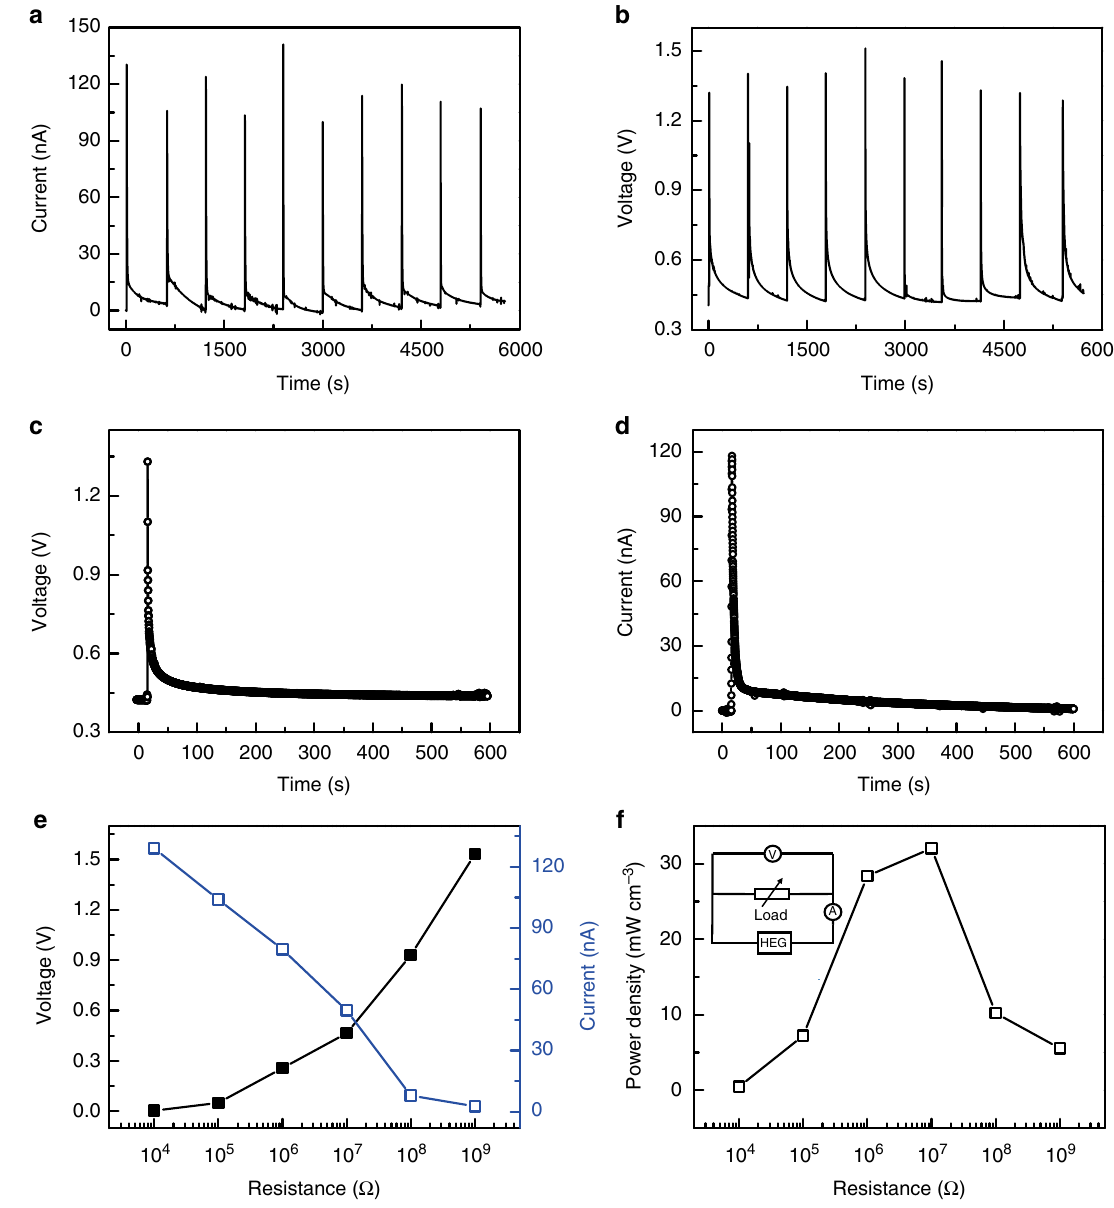
Fig. 3 Electric output performance of hygroelectric generator. a , b Voltage and current output cycles of HEG (Ag/graphene oxide (GO) – gradient reduced graphene oxide (grGO)/Au) in response to the intermittent and periodic relative humidity variation ( △ RH = 80%). HEG (Ag/GO – grGO/Au) is composed of a pair of Au, Ag electrodes, and heterogenous graphene oxide (h-GO) in which the Au electrode contacts with graphene oxide (GO) side of h-GO, while Ag electrode contacts with gradient reduced graphene oxide (grGO) side of h-GO. c , d A single and representative cycle voltage and current output of HEG (Ag/GO – grGO/Au). e , f Output voltage (black curve, e ), current (blue curve, e ), and power density ( f ) of the HEG (Ag/GO – grGO/Au) with different electric resistors. The inset is an equivalent circuit